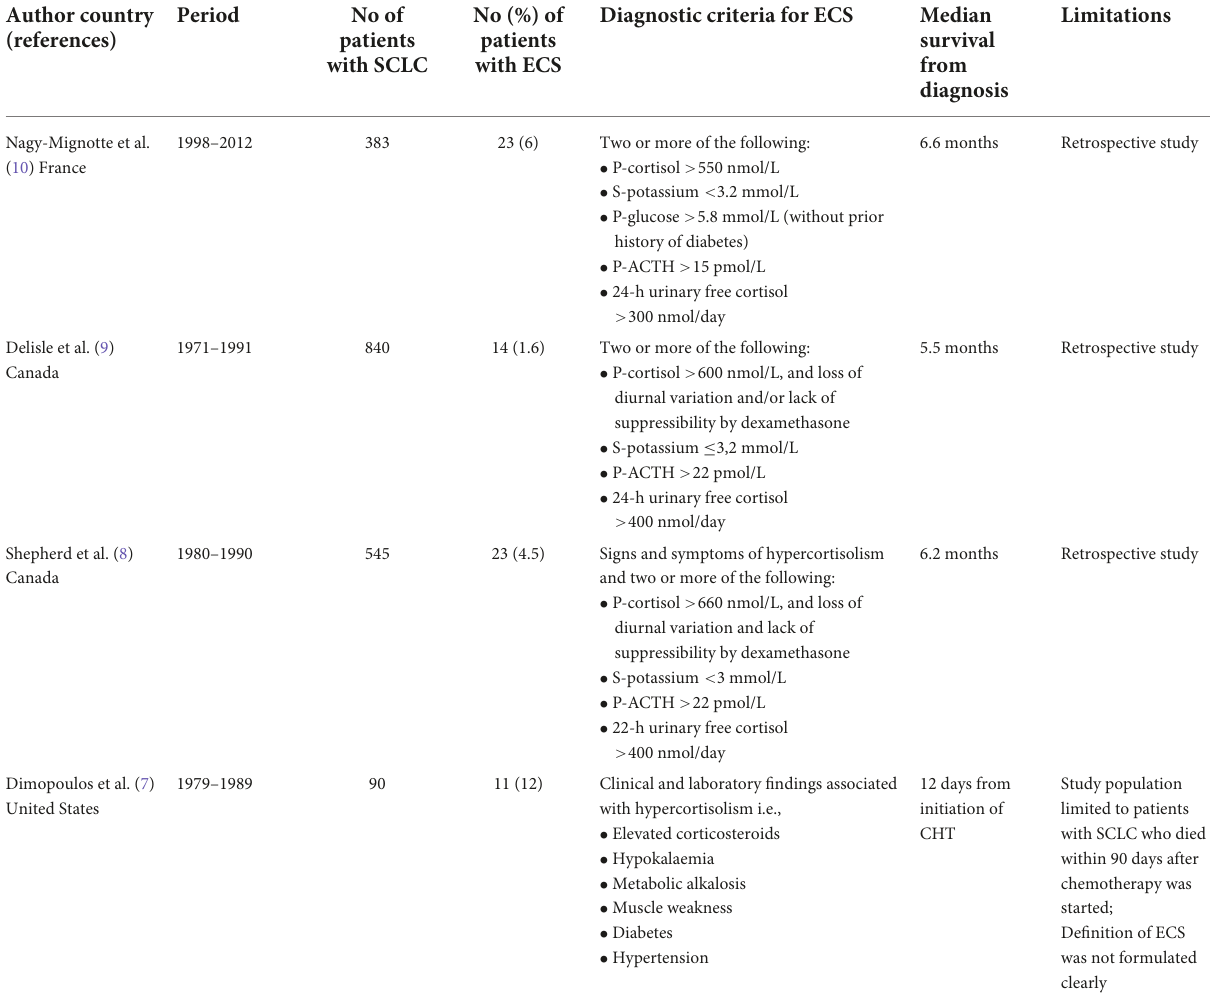
TABLE 3 Summary of previous studies describing the prevalence of ECS among patients with